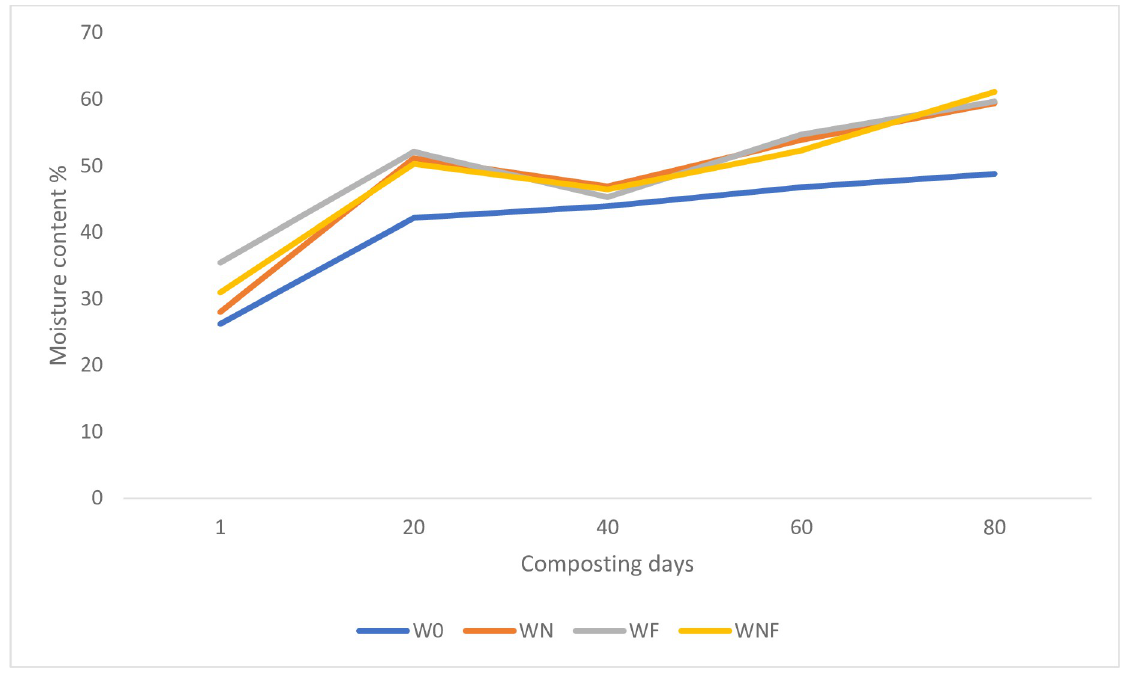
Fig 2. Moisture content during composting of willow